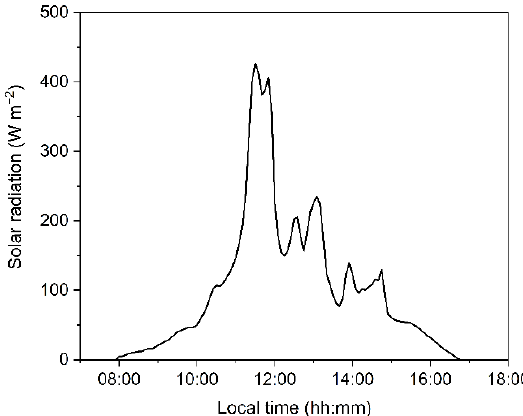
Figure A1. Meteorological data derived from the Meteorological Observatory of the Botanical Gar-